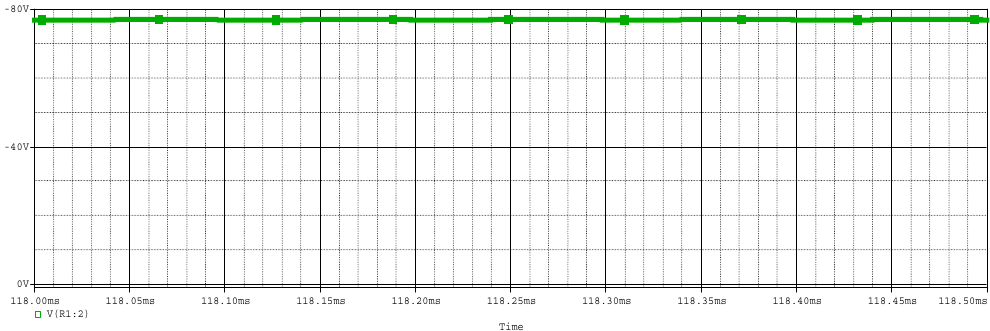
Figure 30. Output voltage of the bidirectional CUK converter [33].